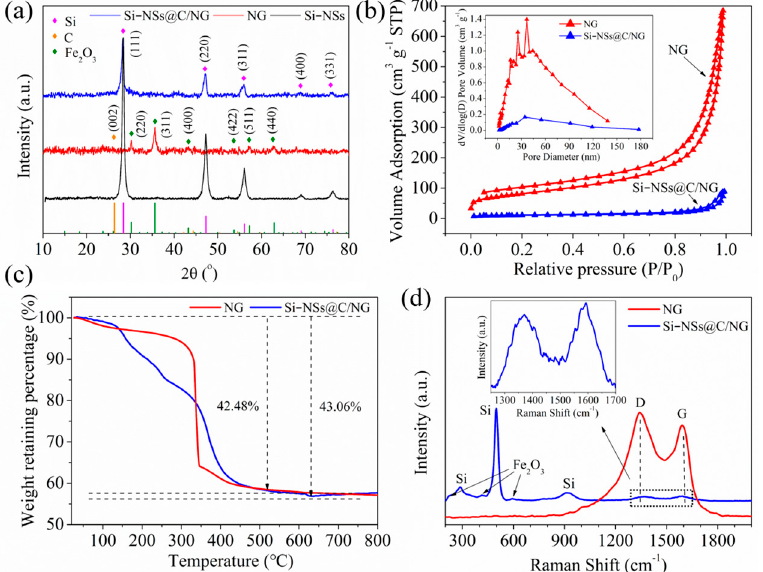
Figure 2. ( a ) XRD patterns of Si–NSs, NG, and Si–NSs@C/NG; ( b ) nitrogen adsorption–desorption isotherms of NG and Si–NSs@C/NG along with the pore size distribution (inset); TGA curves ( c ) and Raman spectra ( d ) of NG and Si–NSs@C/NG.